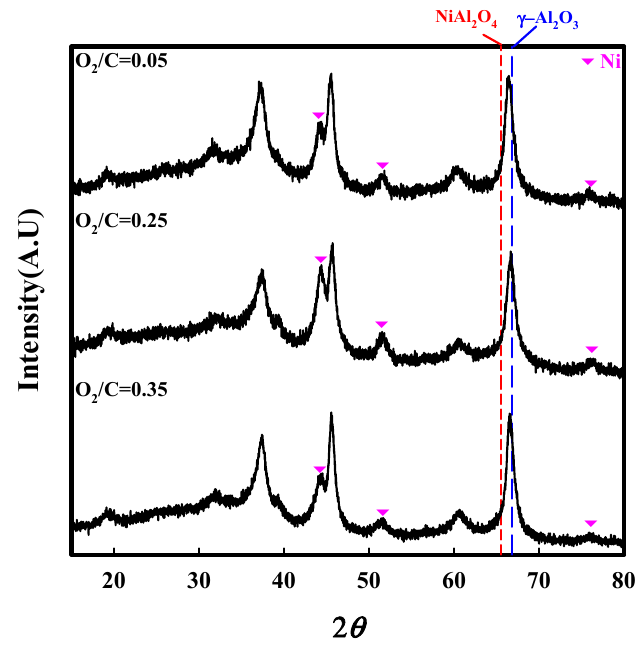
O /C=0.05 O /C=0.05 2 2